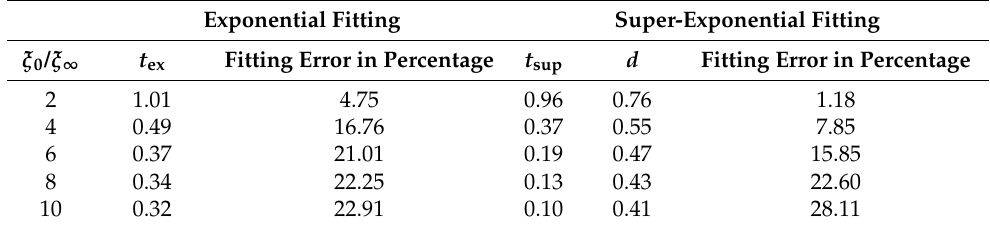
Table 2. The same as in Table 1, but for δ − δ v = − 0.5.